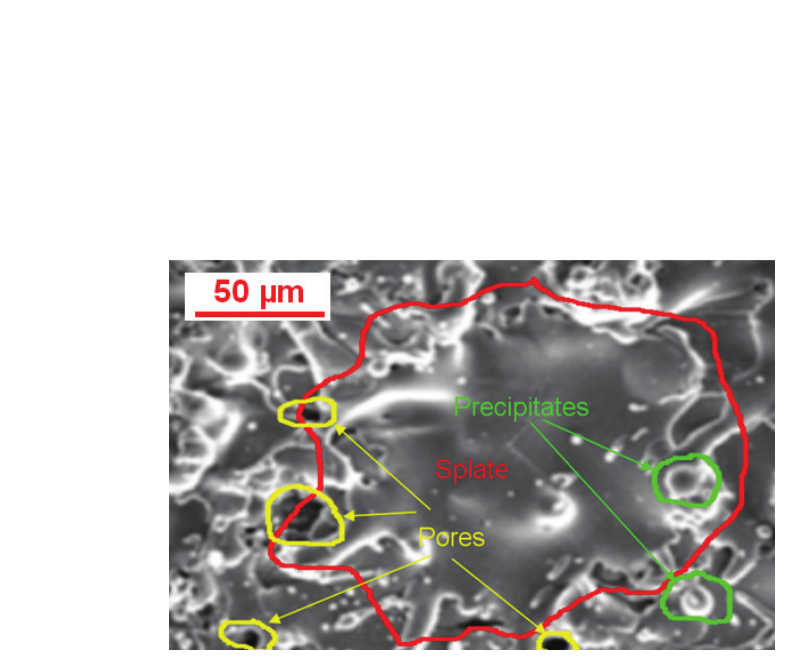
Figure 8 – (SEM) Surface morphology of the coatings deposited from a distance of 110 mm Рис . 8 – (SEM) Морфология поверхности покрытия , нанесенного с расстояния 110 мм Слика 8 – (SEM) Морфологија површине превлаке депоноване са одстојањем 110